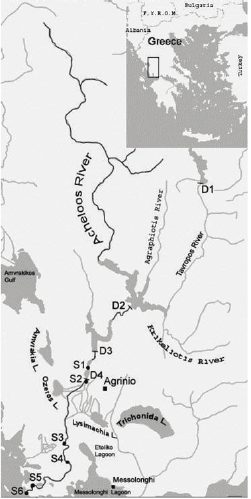
Figure 1: Map of the six sampling sites: S 1 : bridge at village Matsouki,S 2 :afterthedamofStratos,S 3 :aftertheoutflowofWWTP of Agrinio, S 4 : bridge between villages Neochori and Katochi, S 5 : 5 km before the river mouth, S 6 : the river mouth, and four hydroelectric dams (D 1 : Tavropos, D 2 : Kremasta, D 3 : Kastraki, and D 4 :